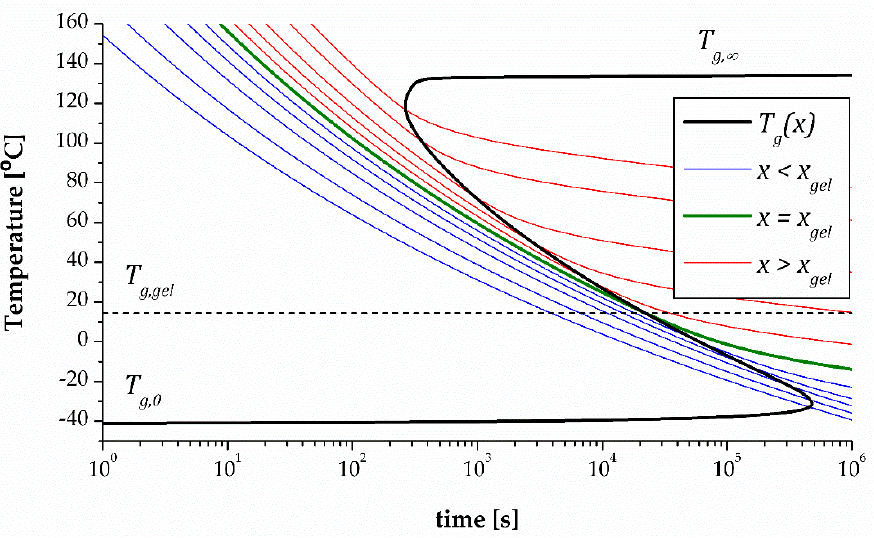
Figure 5. Time-temperature-transformation (TTT) diagram for a DGEBA-diethylenetriamine system, produced from the data reported in the literature [46].